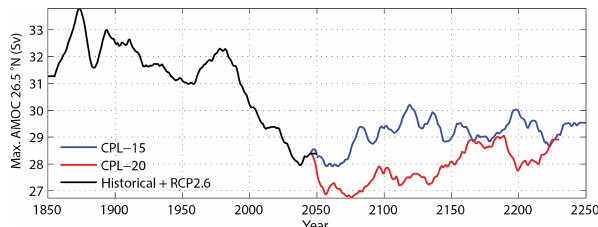
Figure 4. Time evolution of the maximum in the AMOC (Atlantic meridional overturning circulation) at 26.5 ◦ N in Hist1, RCP2.6 (black) and in the 1.5 ◦ C (red) and 2.0 ◦ C (blue) warming exper- iments with NorESM1-Happi. A 10-year running average is used for all curves. Units are in